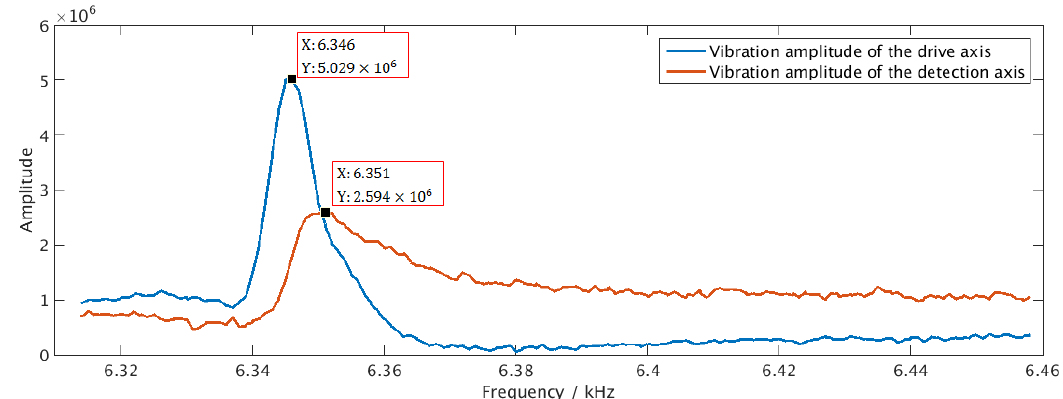
Figure 11. Sweep frequency curves of the drive axis and detection axis of the gyro.